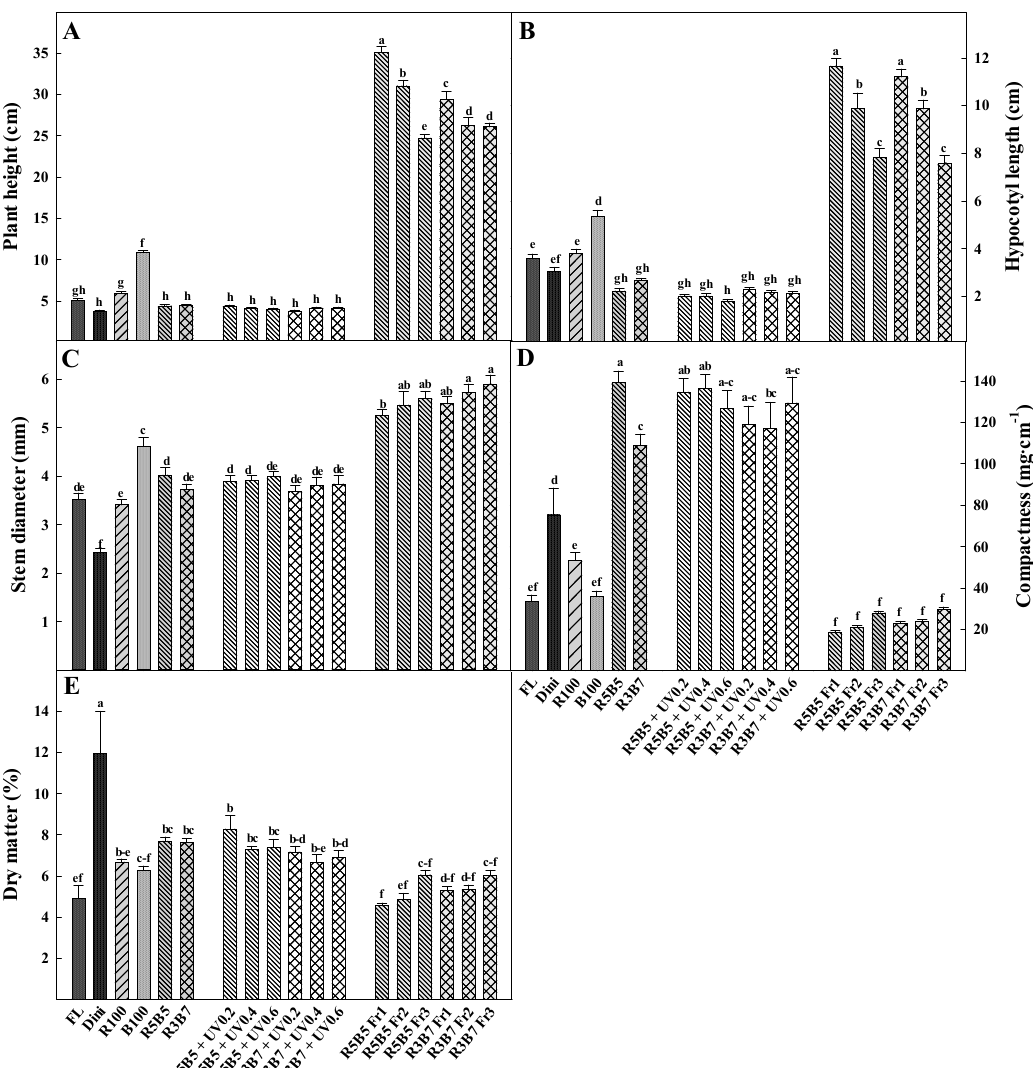
Figure 3. The effects of the light quality on ( A ) plant height, ( B ) hypocotyl length, ( C ) stem diameter, ( D ) compactness, and ( E ) dry matter of “Joeunbaekdadagi” cucumber ( Cucumis sativus L.) plants measured at 22 days after treatment. Vertical bars indicate the mean ± SD. ( n = 15). Different letters above the bars indicate significant differences by Duncan’s multiple range test at p ≤ 0.05.